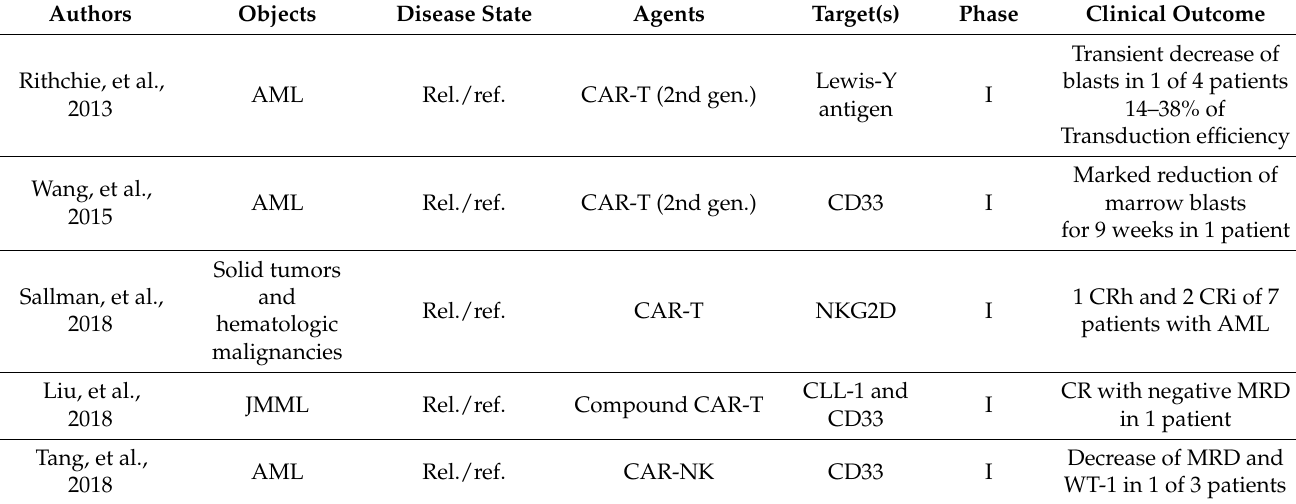
Table 2. A summary of early phase trials of CAR-T and CAR-NK therapy. JMML: juvenile myelomonocytic leukemia, Rel./ref.: relapsed or refractory, CR: complete remission, CRh: CR with partial hematologic recovery, CRi: CR with incomplete hematologic recovery, MRD: minimal residual